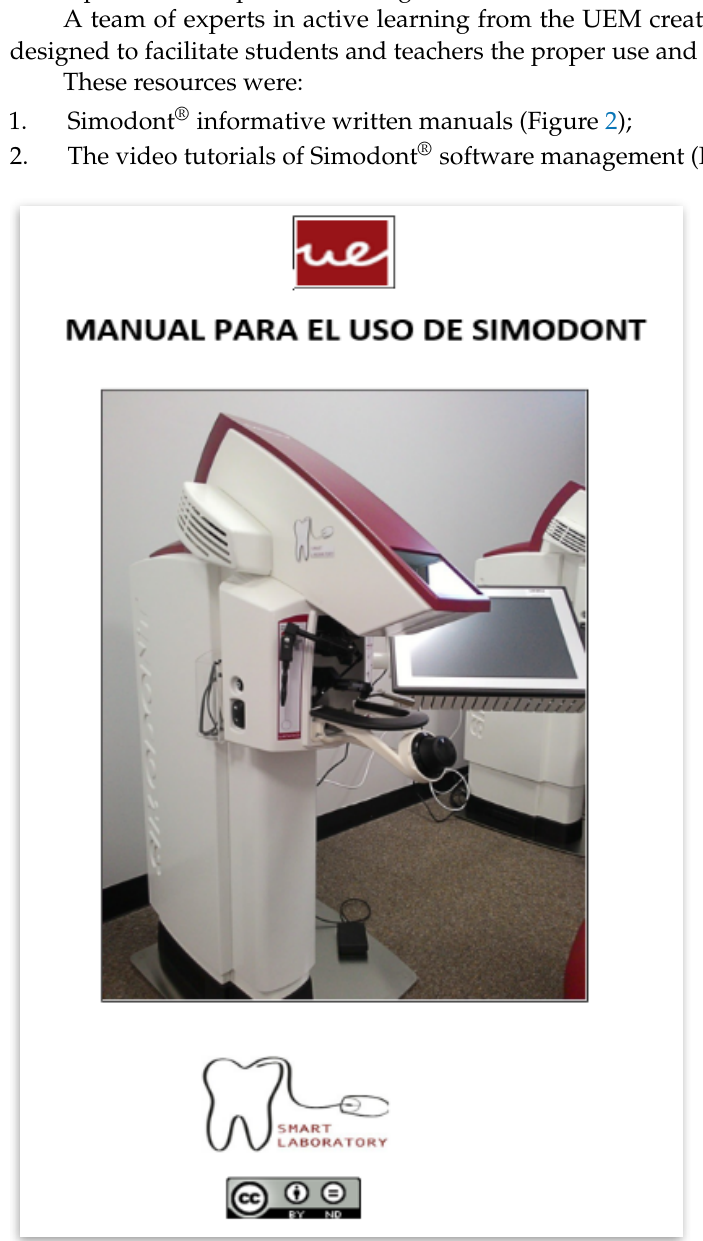
Figure 2. Simodont ® infographic manual. Source: Courtesy of the author. Written permission of NISSIN Dental.